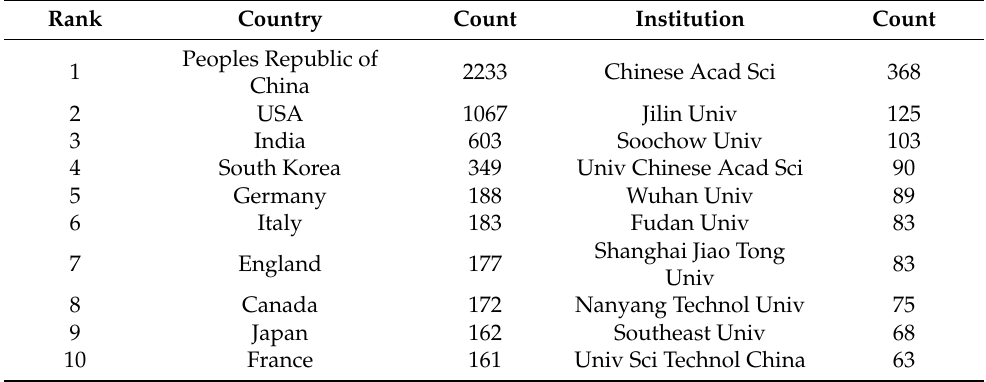
Table 2. The top 10 countries and institutions that contributed to publications on QDs toxicity research.